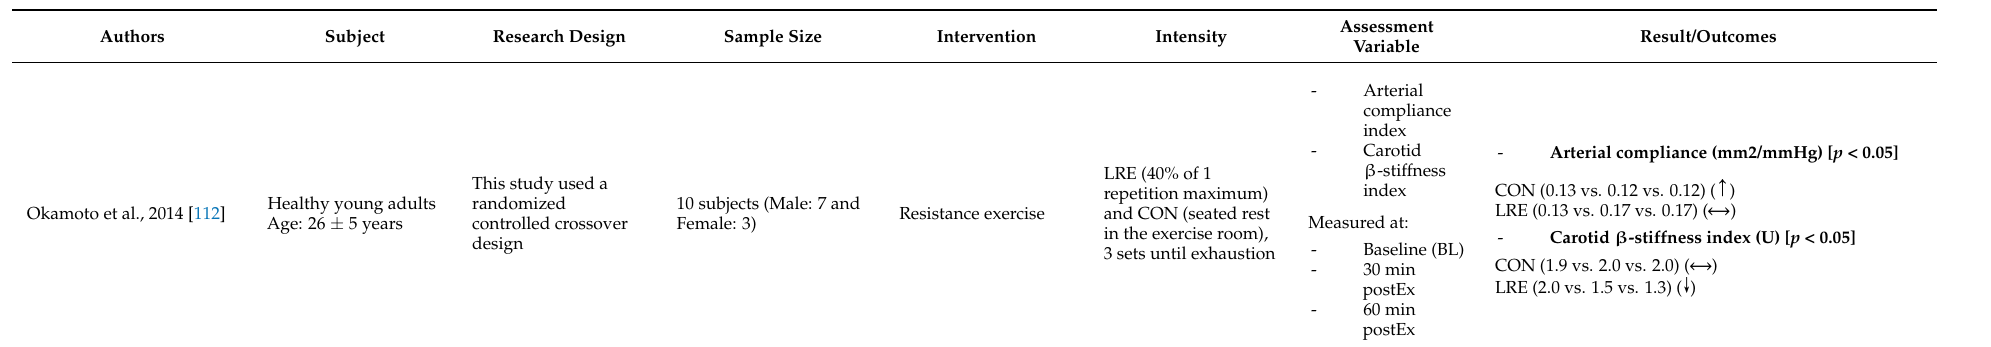
Table 1. Summary of the associations between metabolic impairments and arterial stiffness.